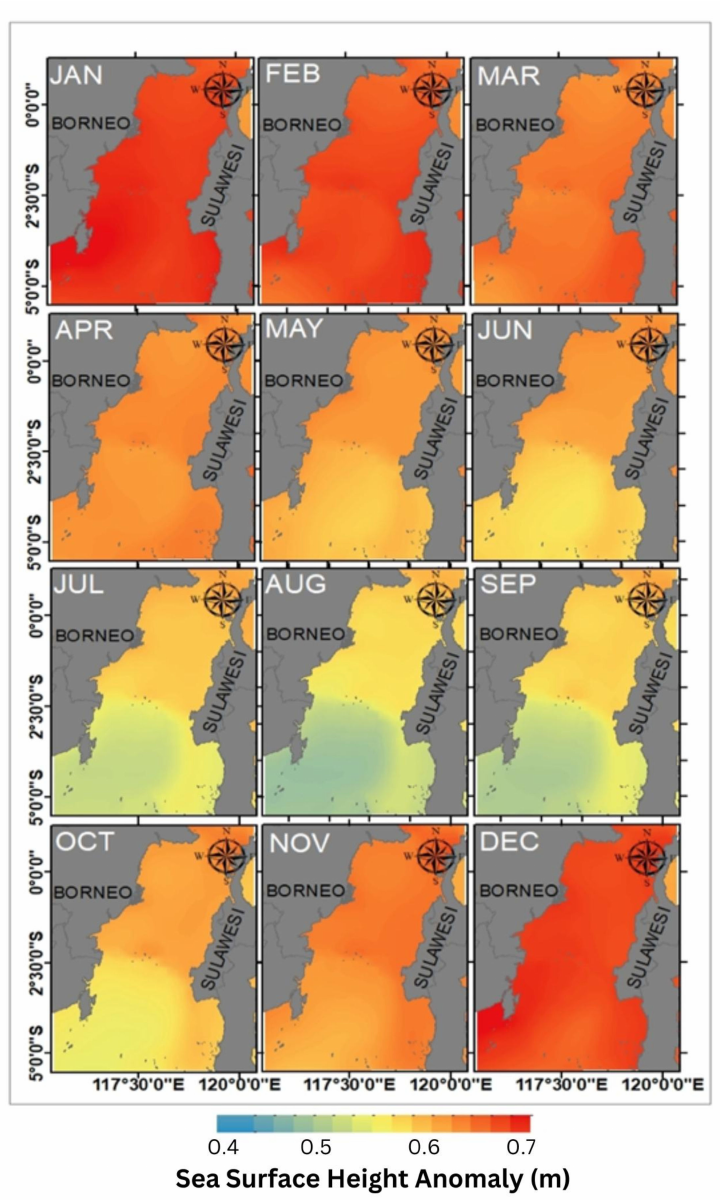
Figure 6. The Spatial Distribution Map of Average Sea Surface Height 2015–2020 in the Makassar